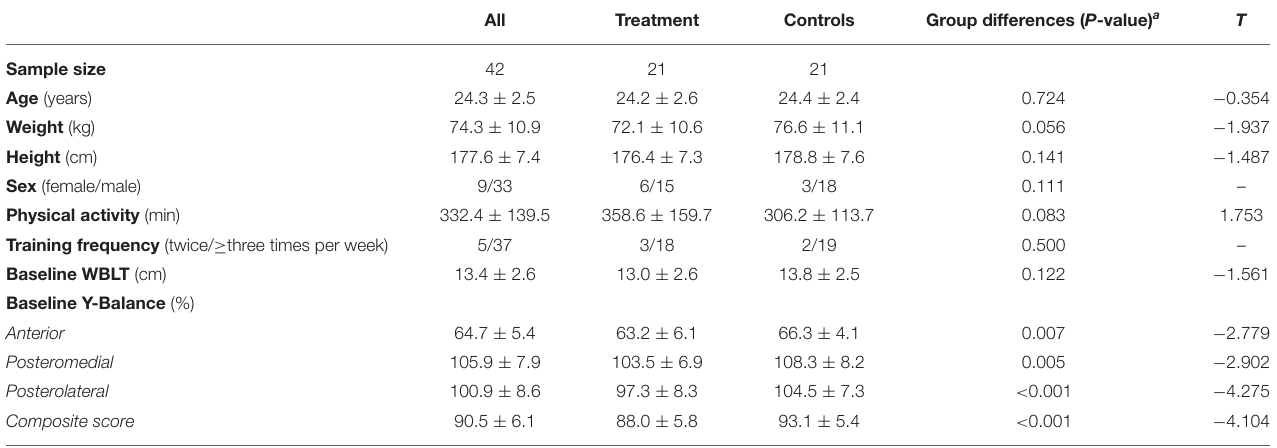
TABLE 1 | Participant characteristics and baseline values of WBLT and Y-Balance test. All Treatment